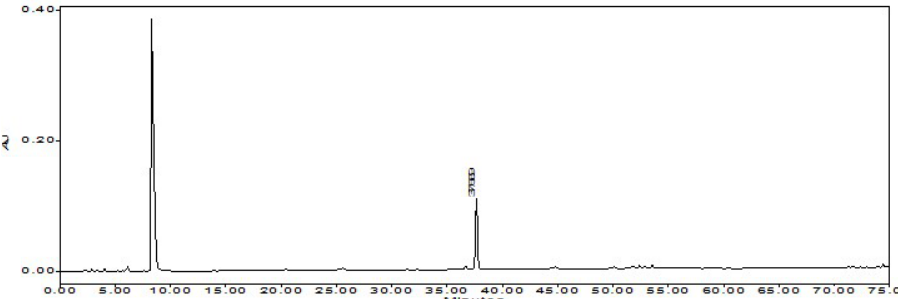
Figure 8. The chromatogram of isolated capsaicin.